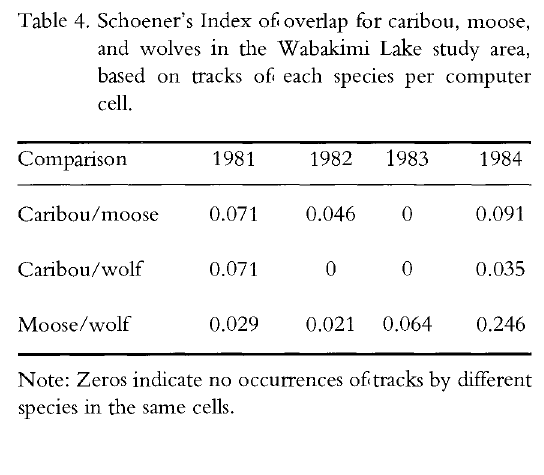
Table 4. Schoener's Index of overlap for caribou, moose, and wolves in the Wabakimi Lake study area, based on tracks of each species per computer cell.